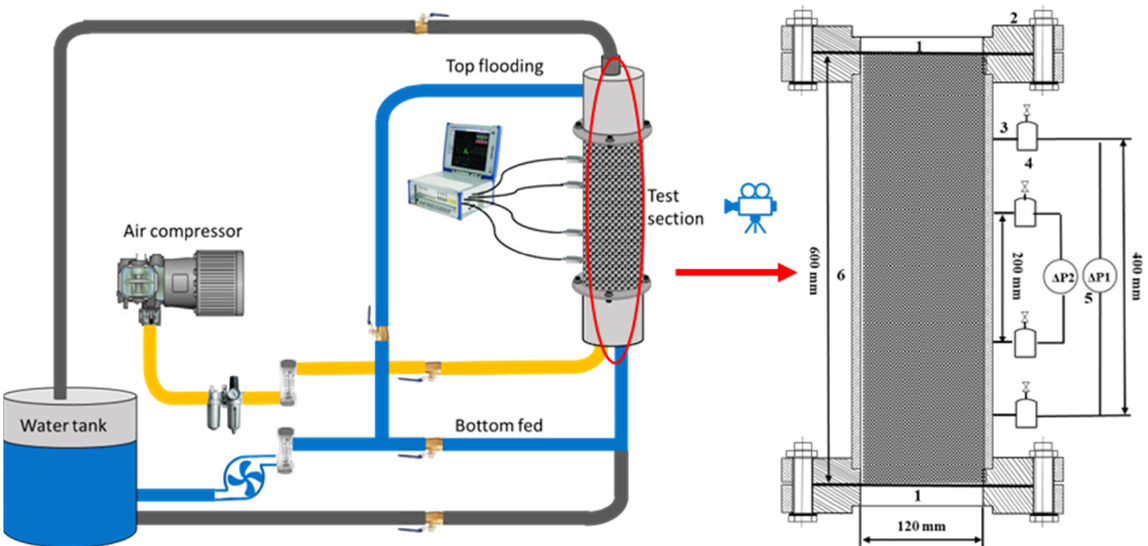
Figure 1. Diagram of DEBECO-LT and test section. 1—Stainless steel wire mesh, 2—Fittingflange, 3—Connecting pipe, 4—Gas–liquid separator, 5—Differential pressure transmitter, 6—Test section.